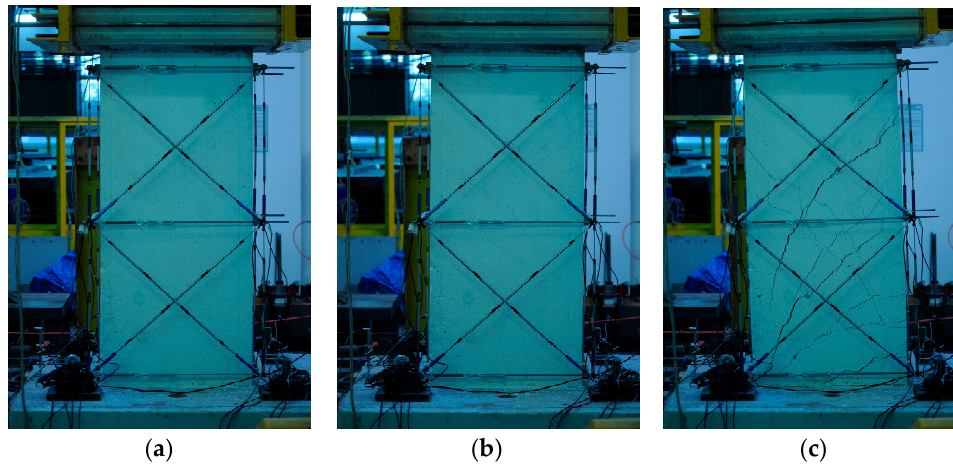
Figure 18. Pier images during the cyclic test at time: ( a ) test beginning; ( b ) first shear cracking at fourth drift and ( c ) final crack pattern—rectangular pier.